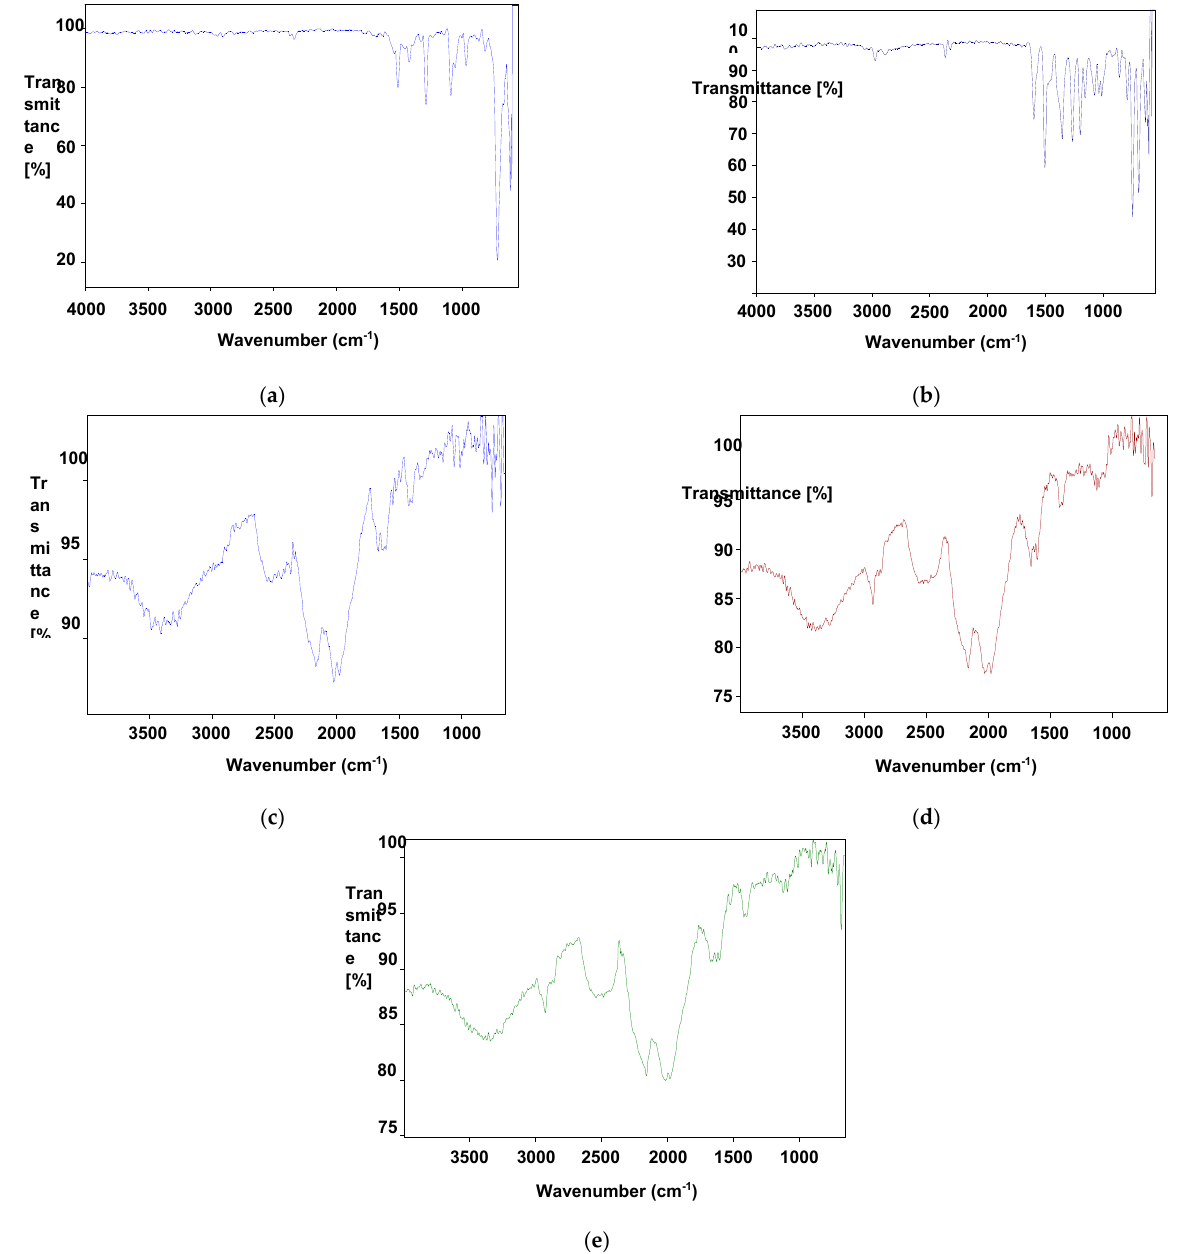
Figure 4. FT-IR spectra of ( a ). NMPY), ( b ) NNDEA, and ( c – e ) PNMPY-TRX100/NNDEA/OL 37 electrodeposition over OL 37 electrode at galvanostatic method ( c ) 3 mA/cm 2 , ( d ) 5 mA/cm 2 , ( e ) 8 mA/cm 2 in 5:1 molar ratio for MPY-TRX100: NNDEA and permitted for 20 min.